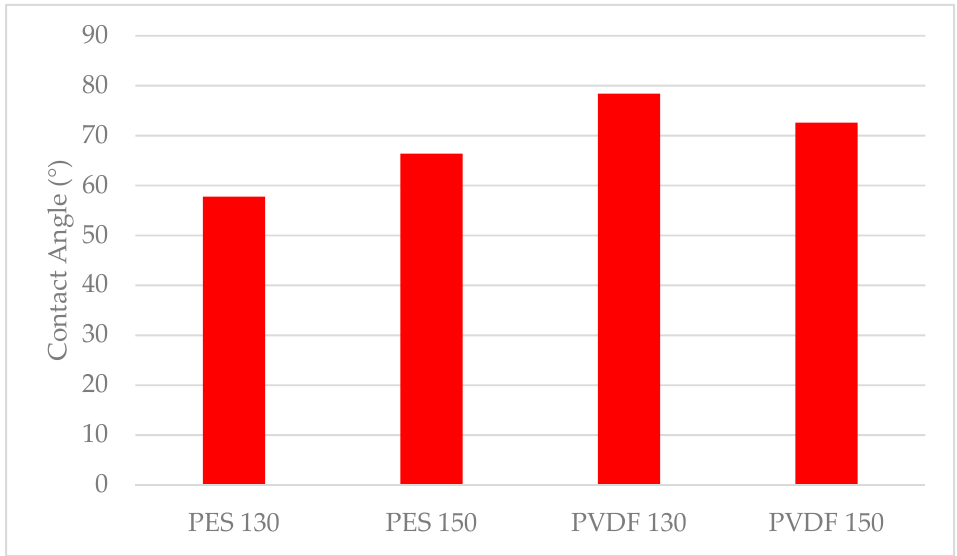
Figure 7. Membrane surface contact angles in degrees.